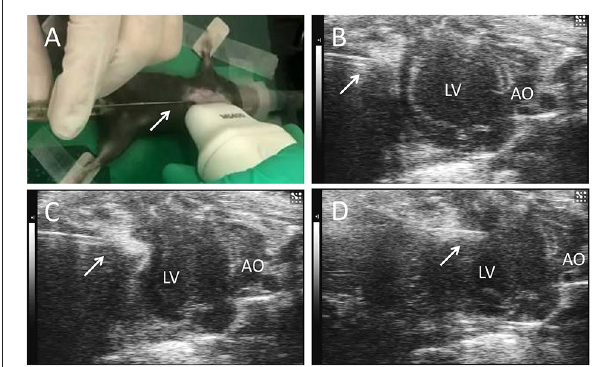
FIGURE 1 | Echocardiography-guided percutaneous left ventricular intramyocardial injection. Mice were anesthetized and maintained via isoflurane (1.5 − 2%) inhalation. After depilation locally, and guided by transthoracic echocardiography, the needle (arrows) of a microsyringe was inserted below the xiphoid process (A) and along the upper margin of the liver (B) , entered the pericardial cavity (C) , and finally was injected into the anterior wall of the left ventricle (D) to deliver the cells. LV, left ventricle; AO, ascending aorta.